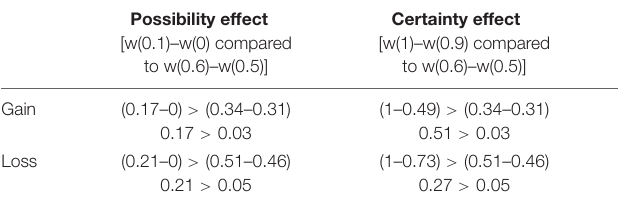
TABLE 5 | Possibility and Certainty effect in gain and loss domains.